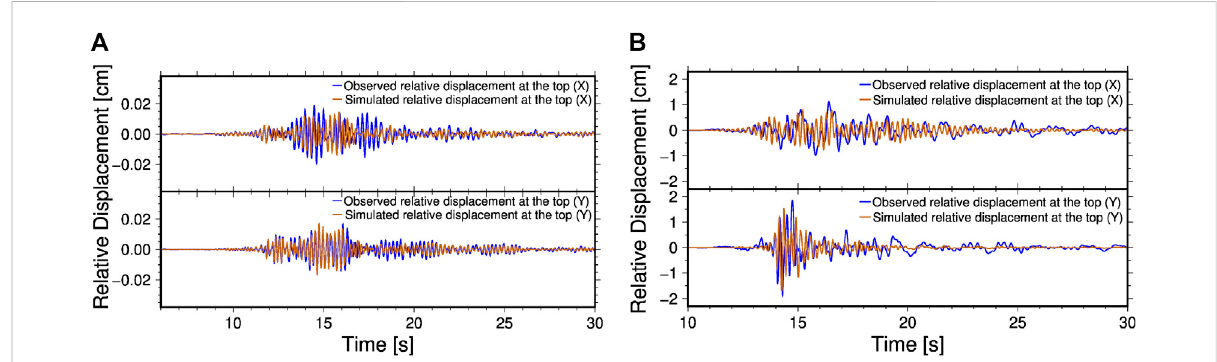
FIGURE 4 Observed(blue)andsimulatedrelativedisplacements(orange)atthetopofthebuildingforanM3.9eventof30-11-2013 (A) andtheM6eventof 24-08-2016 (B) for the two main directions of the building (X and Y).